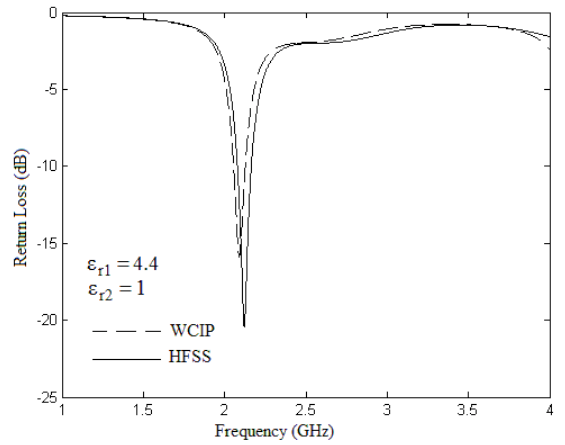
Figure 8: Return loss versus frequency for suspended microstrip circular patch